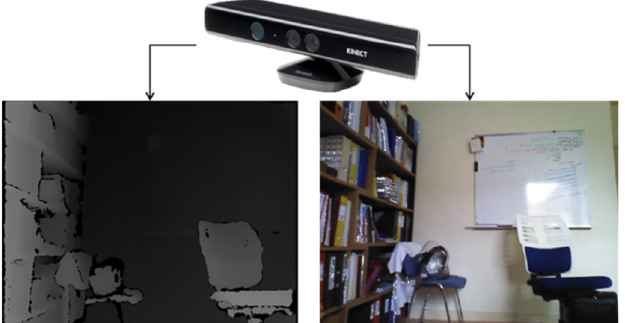
Fig. 1. Outcoming data from 3D sensor (left: depth-map, right: